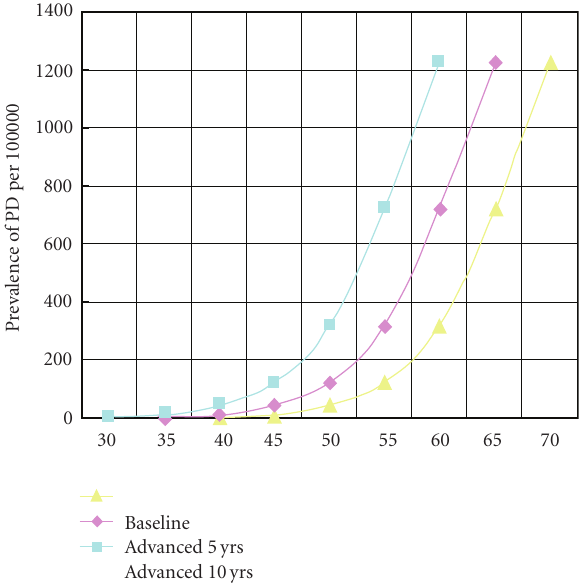
Figure 6: The chart demonstrates how the age-adjusted functions of a disorder such as Parkinson’s disease are modified by an acceleration of cell loss as depicted in Figure 5. At age 65 years, the prevalence without acceleration is, based on available data, about 700/100,000. If advanced by 5 years, the prevalence would be